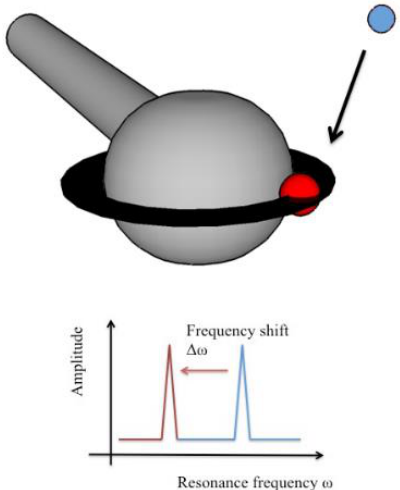
Figure 1. A model for WGM optical microcavity detection, based on [41] (adapted with permission). In the top image, light (thick black line around the device) enters a